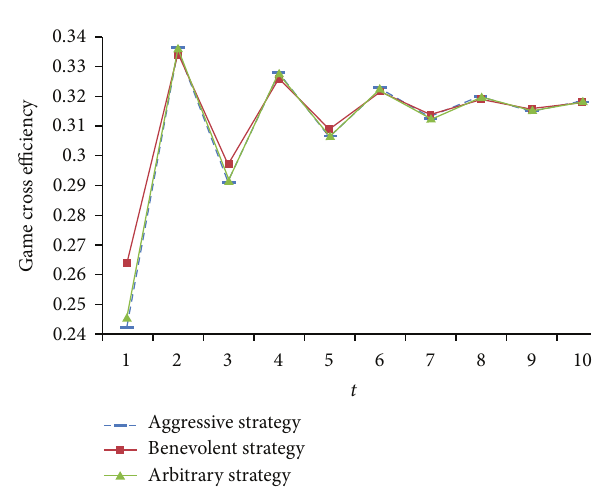
Figure 2: Iteration process for